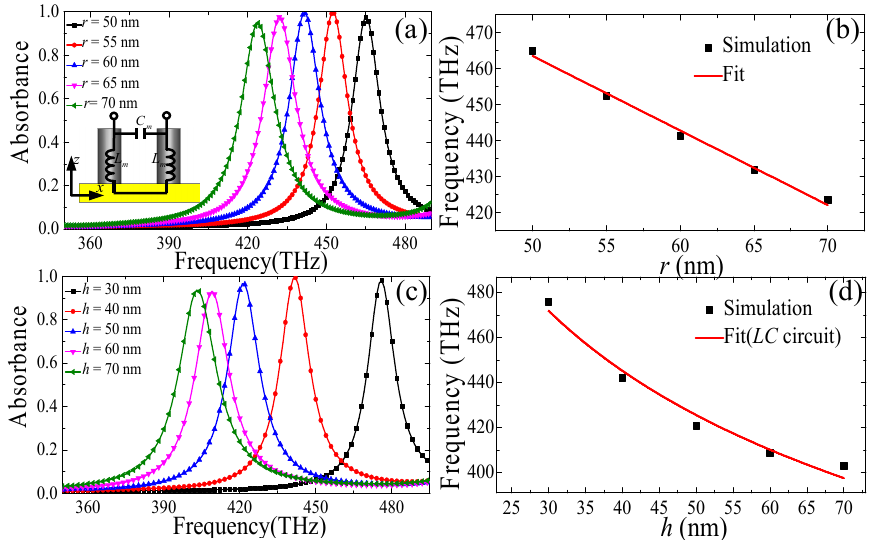
Figure 3. ( a , c ) Simulated absorbance of the PPA in different r and h of SNRR structure and ( b , d ) the dependences of the resonant absorption frequency are as functions of r and h .